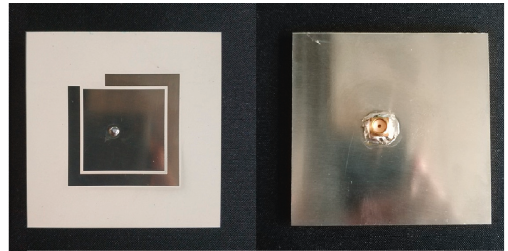
Figure 12: The fabricated CP microstrip antenna with the C-shaped parasitic strip.